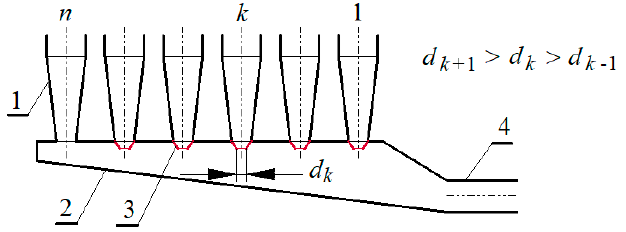
Figure 9. The principle of selecting a choke adapter: 1—cyclone, 2—sedimentation basin, 3—cap, 4—suction port. 4—suction